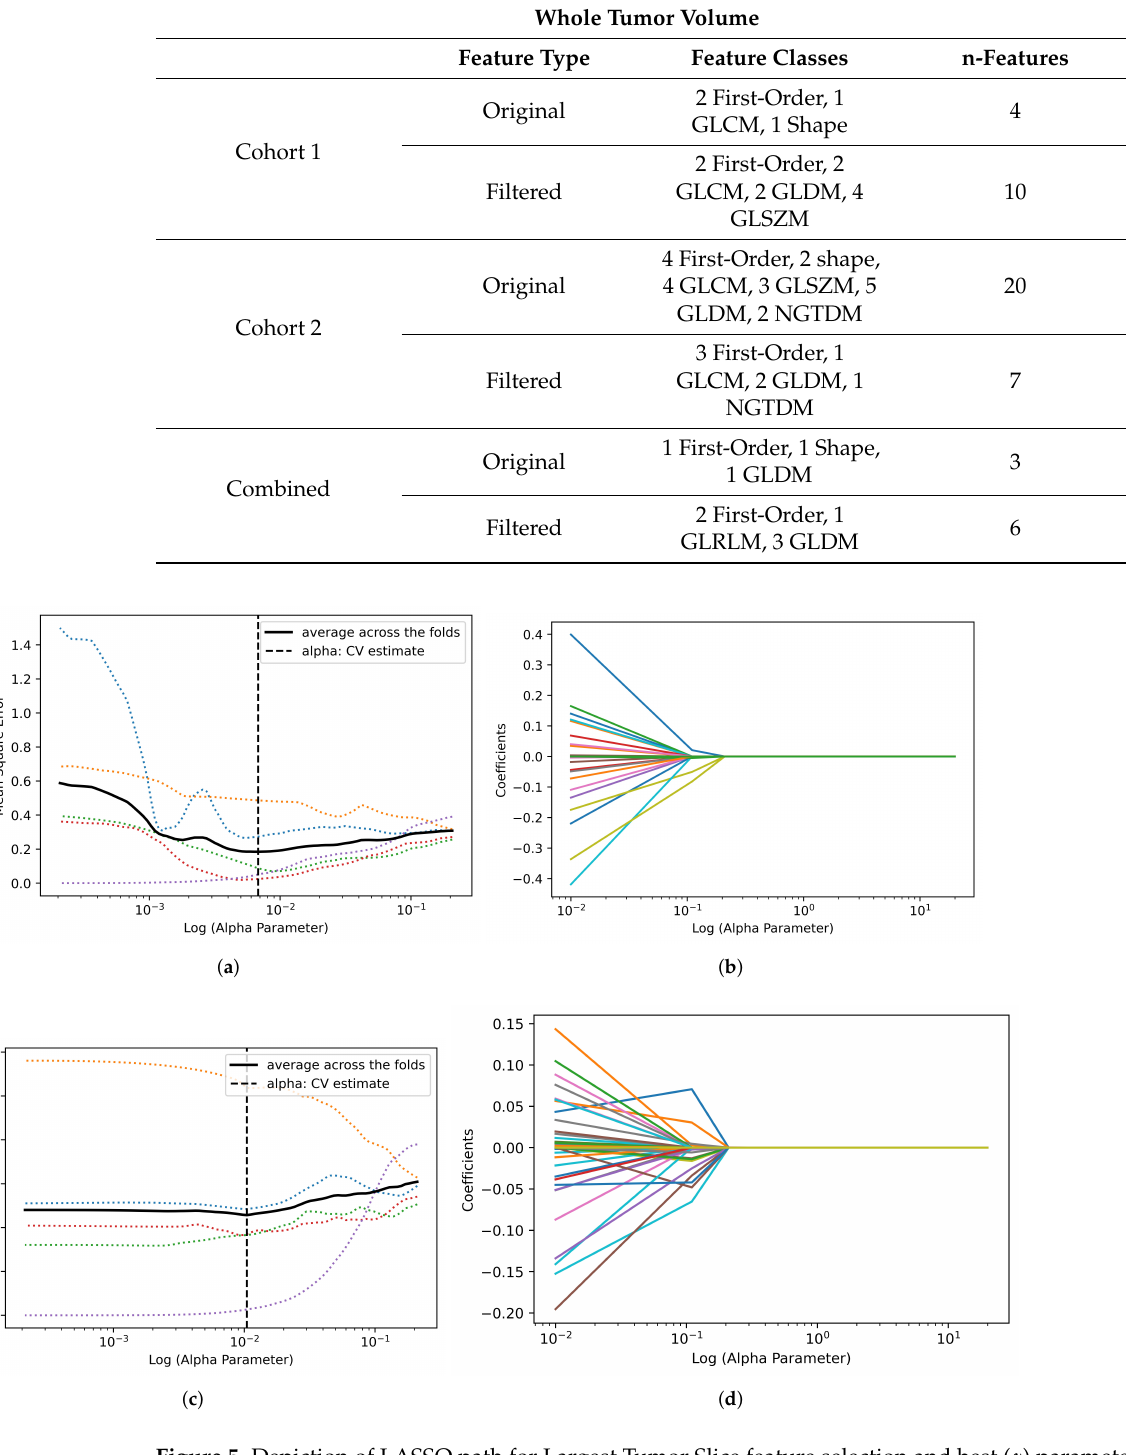
Figure 5. Depiction of LASSO path for Largest Tumor Slice feature selection and best ( α ) parameter estimation for cohort 1. The black line indicates the mean square error across the five folds. ( a ) Best log ( α ) estimation for 2D original features. The best ( α ) estimation parameter was found to be 0.11 presented in vertical black dotted line. ( b ) 2D original feature selection LASSO coefficient path, 4 features were selected. ( c ) Best log ( α ) estimation parameter for 2D filtered features. The best ( α ) estimation parameter was found to be 0.11. ( d ) Highlights the 2D filtered feature selection LASSO coefficient path, 14 features were